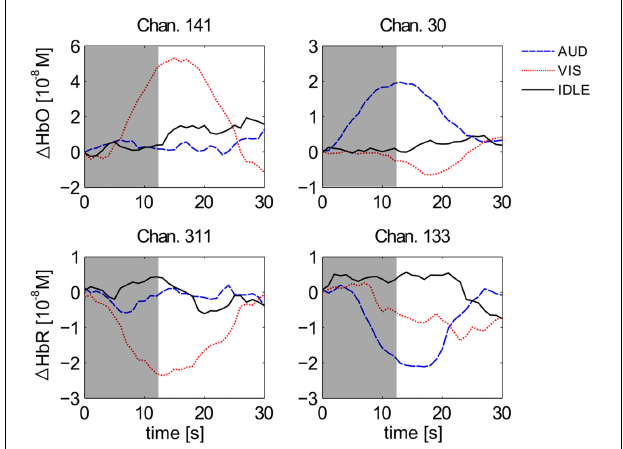
FIGURE 5 | Grand averaged ERPs of all 3 conditions at 4 different channel locations. Depicted are averages for the classes AUD (blue), VIS (red), and IDLE